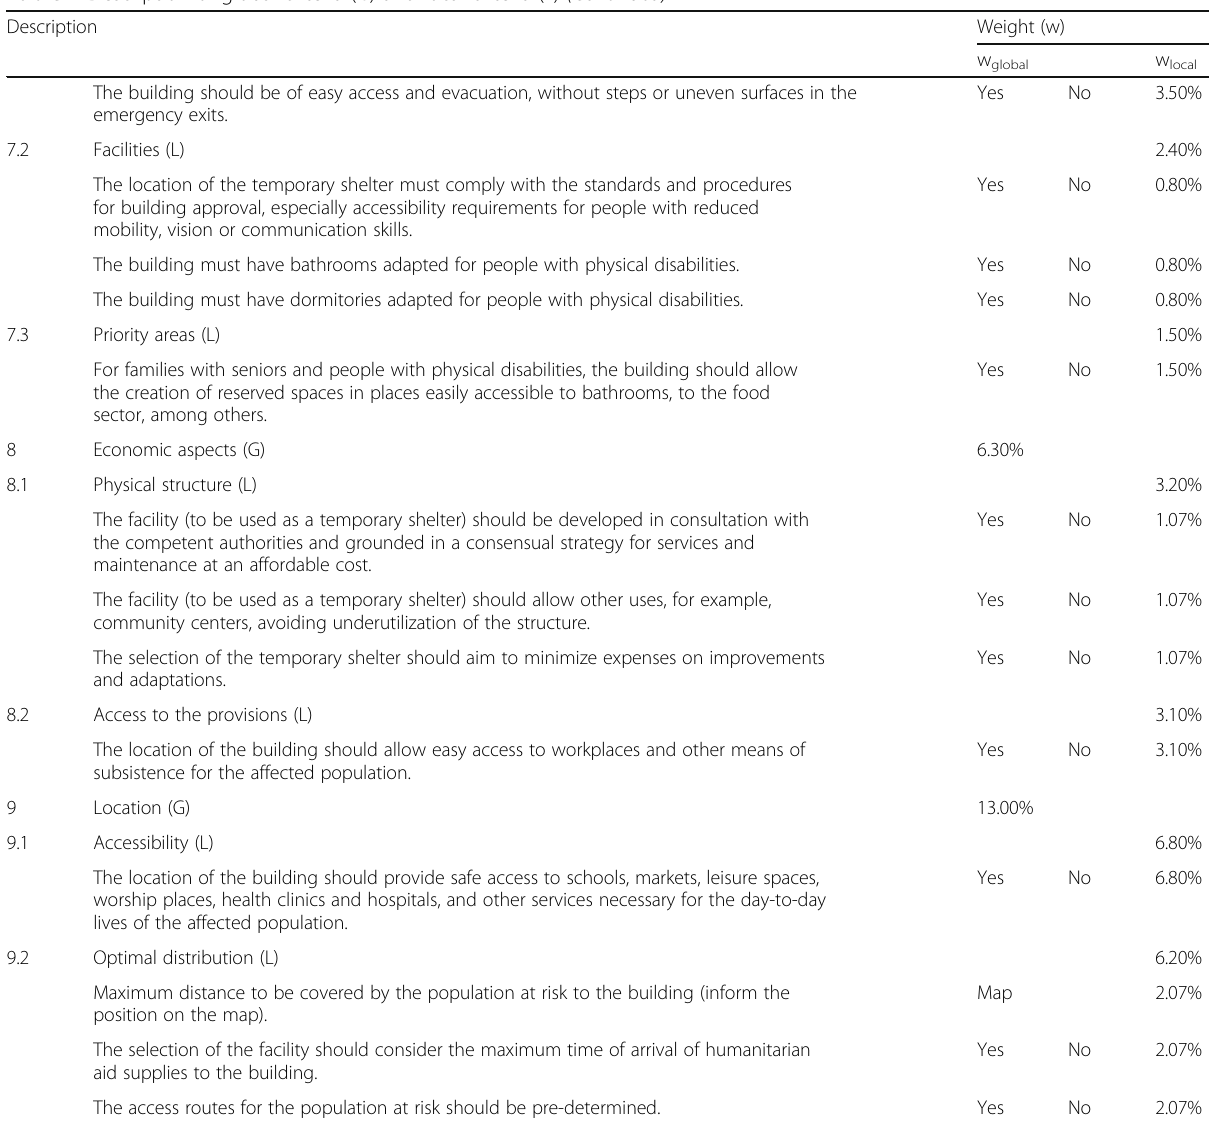
Table 2 Description of global criteria (G) and local criteria (L) (Continued) Description Weight (w)